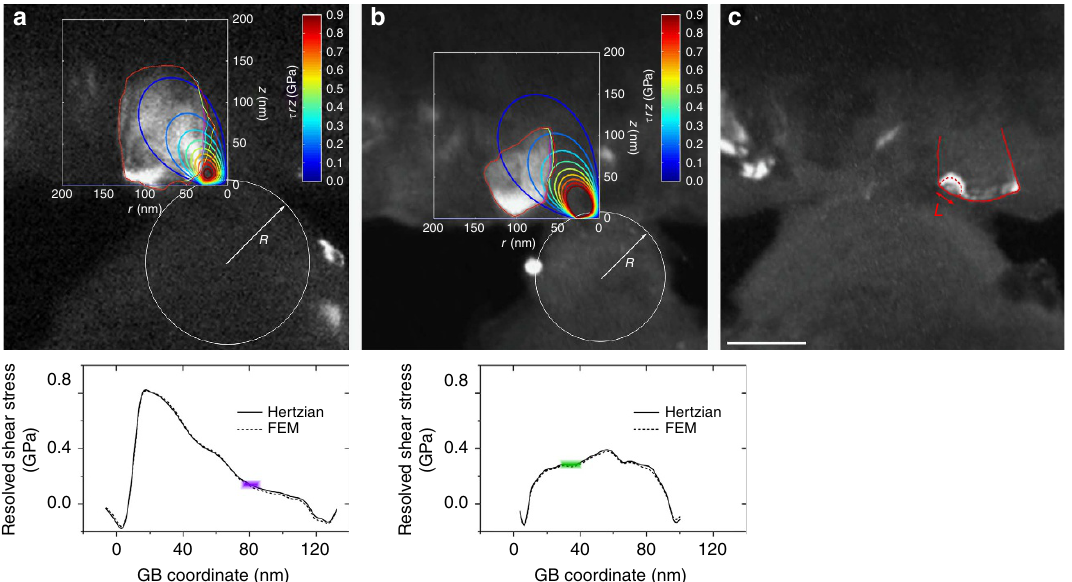
Figure 5 | Quantification of impurity-mediated critical shear stress for GB migration and other deformation mechanisms. ( a , b ) Snapshots at the onset of GB migration in the films with C O of ( a ) 0.7 and ( b ) 2.1at.%, superimposed with subsequent shape evolution of the grains and contour maps of shear stress ( t rz ) calculated using a Hertzian model (see text for details). Lower panels show corresponding profiles of resolved shear stress along the mobile GBs (both occurring on the right side of grains nearest to the indenter tip). Shaded bars denote the location of the onset of GB migration and estimated range of critical shear stress. ( c ) Snapshot of a different experiment showing the emission of dislocation (dash line) from a GB or triple junction (solid line). Scale bar, 100nm. GBs were generally found to be immobile in cases where clear evidence of dislocation propagation was observed, indicating an alternative relaxation